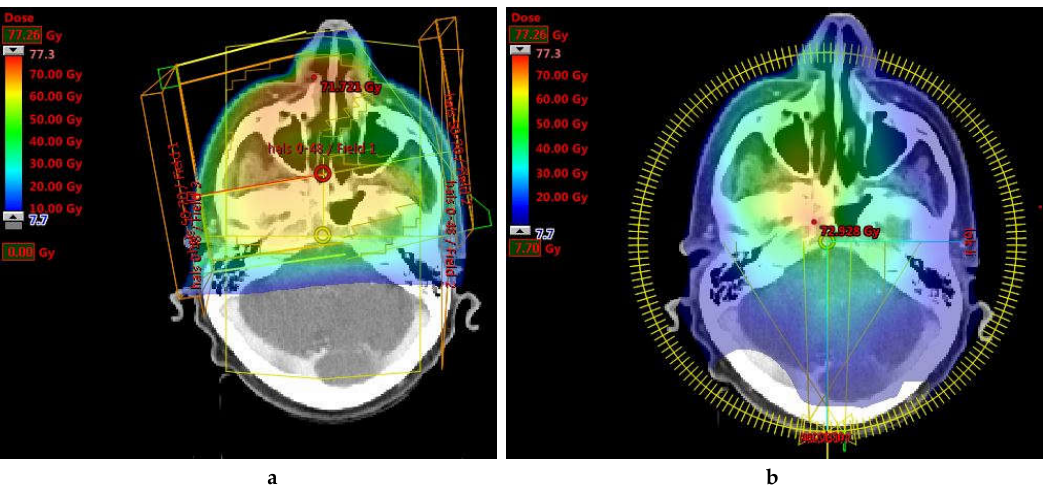
Figure 1. A comparison between a three-dimensional conformal radiotherapy (3DCRT) plan and a volumetric modulated arc therapy (VMAT) plan for a head and neck tumour. Notice the larger volume of the posterior fossa receiving a low dose bath in the VMAT plan. ( a ) 3DCRT; ( b ) VMAT.